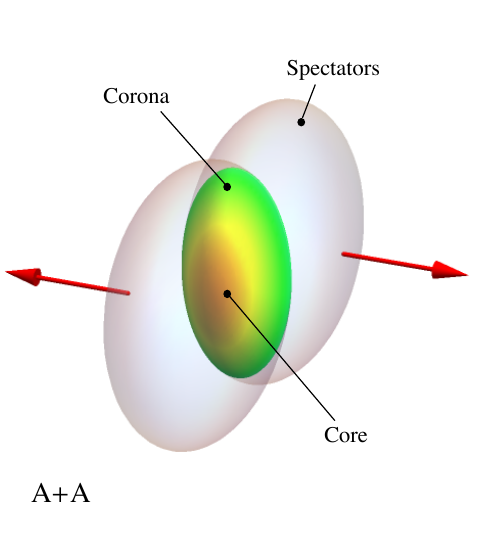
Figure 1. Sketch of a non-central heavy-ion collision. The non-homogeneity density of the fireball is illustrated by the color gradient. The core, in which Λ s and Λ s are produced by QGP processes, and the corona which is dominated by nucleon nucleon/N + N) reactions. The figure is taken from Ref.